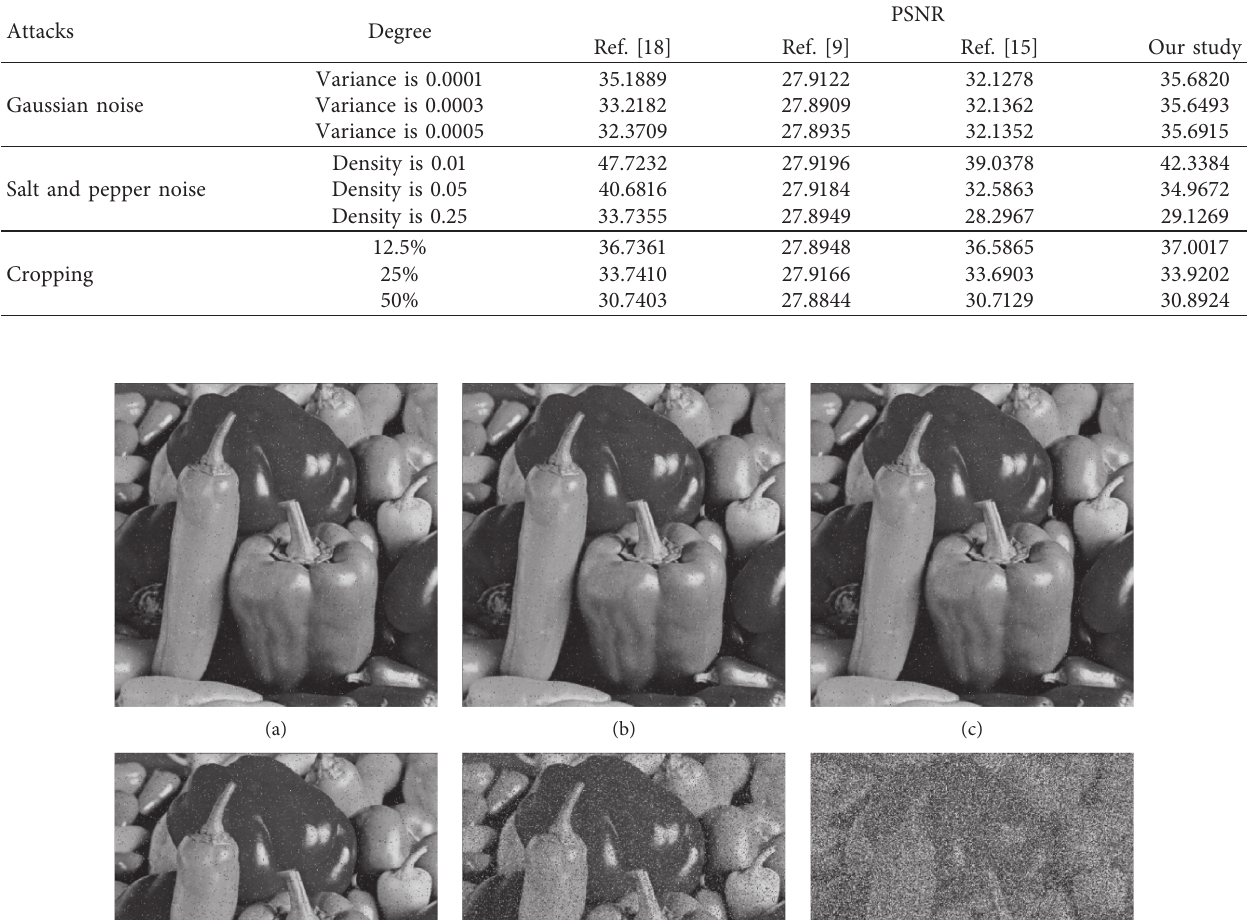
Table 10: MSE and PSNR values.